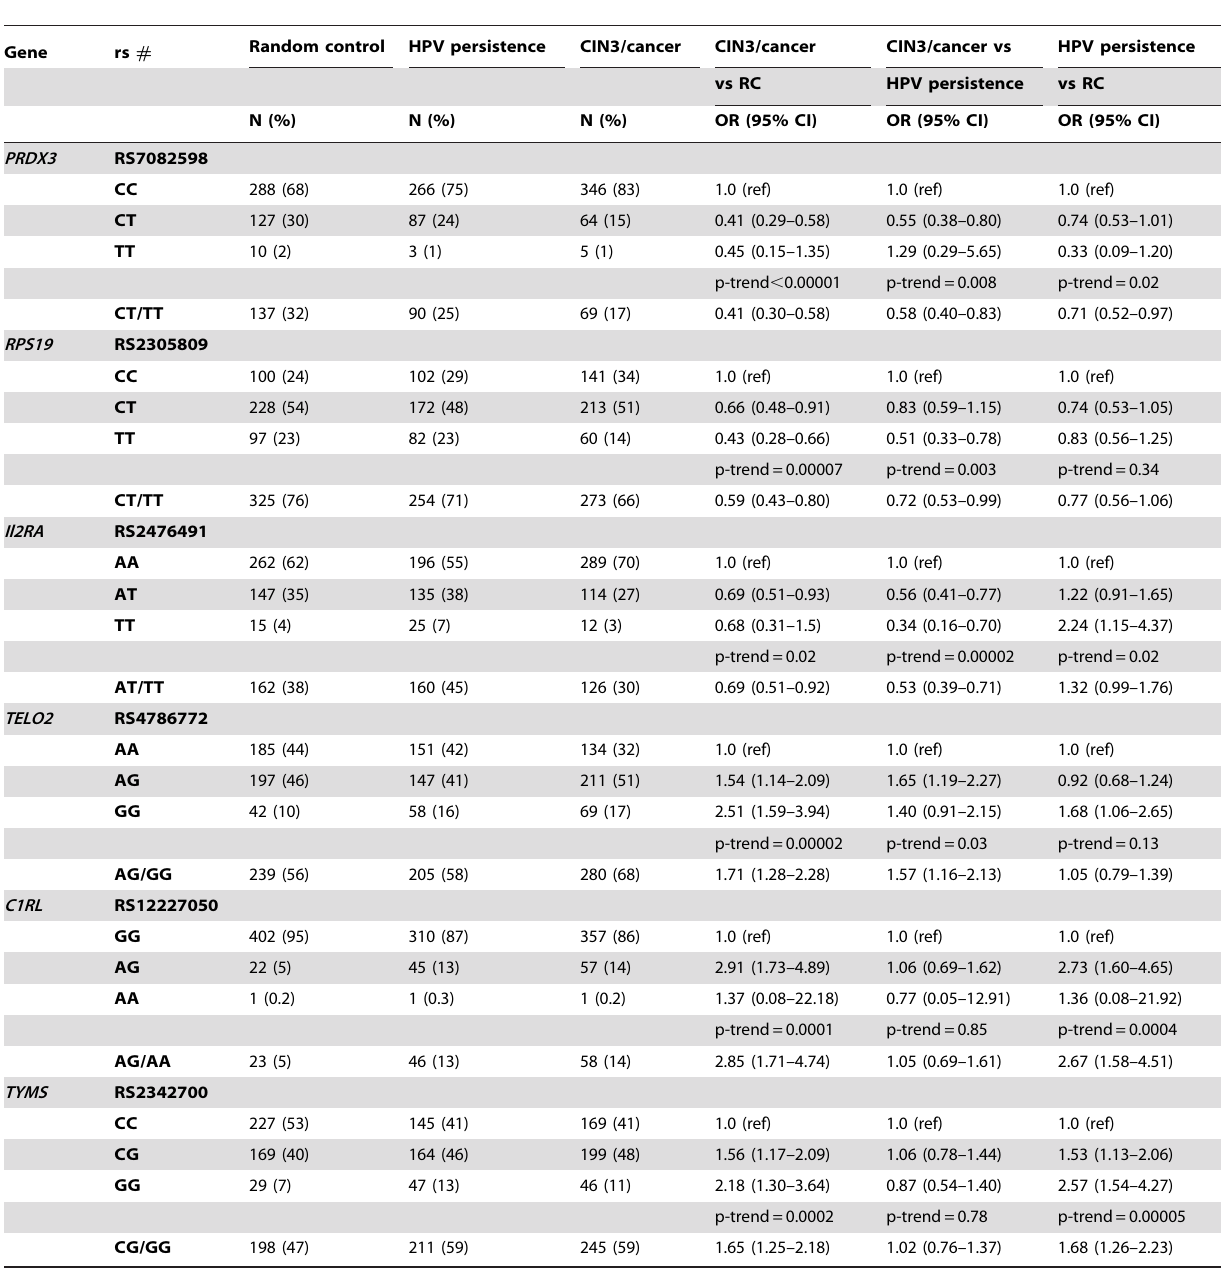
Table 2. Odds ratios and 95% confidence intervals for top-ranked SNPs (p # 0.0001) with either an association with (i) cervical precancer/cancer, (ii) progression to cervical precancer/cancer, or (iii) HPV persistence: (all models adjusted for